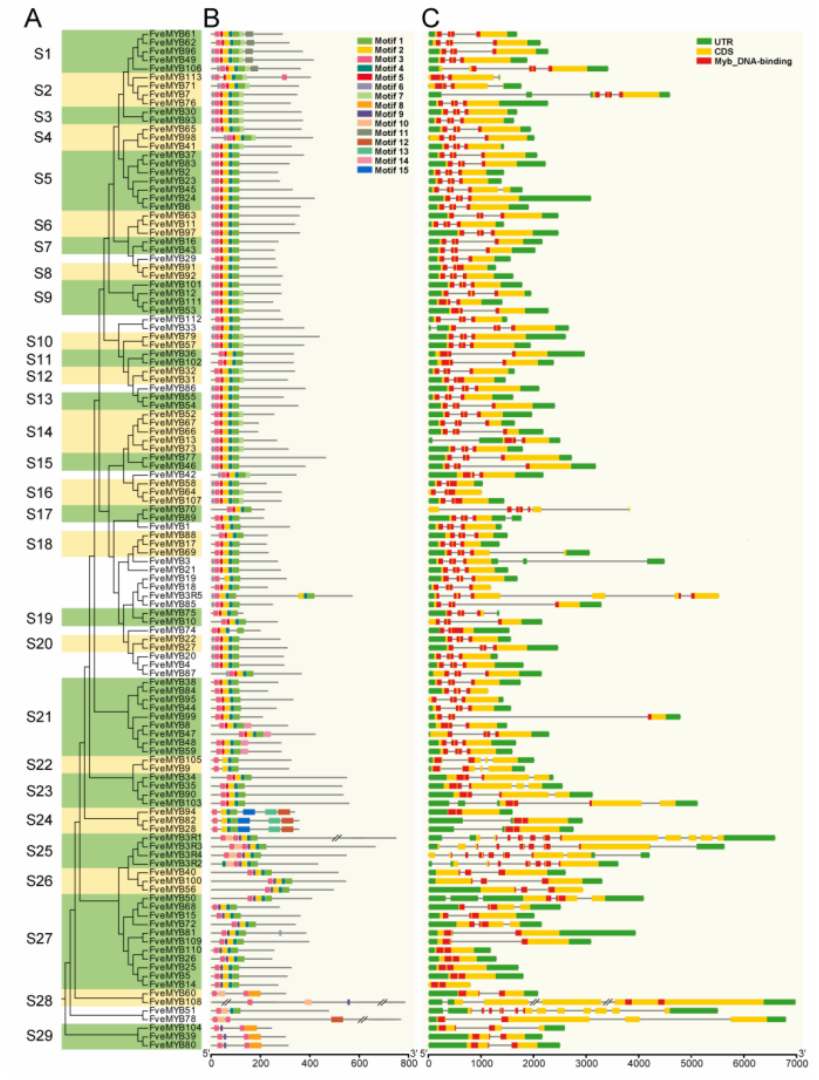
Figure 1. The phylogenetic relationship, conserved motif structure, domain, and intron – exon organization of 2R-MYB and 3R-MYB proteins in woodland strawberry. ( A ) The phylogenetic tree of five 3R-MYB proteins and 113 2R-MYB proteins in woodland strawberry. According to previous study in soybean [26], the phylogenetic tree was divided into 29 subgroups (S1 – S29) based on bootstrap values (>50), which had only one R1R2R3 subgroup. Some proteins were not clustered together due to bootstrap values were below than 50. ( B ) The motif composition of 2R-MYB and 3R-MYB proteins from woodland strawberry. Fifteen motifs were marked with different color boxes. ( C ) The domain composition and intron – exon organization of 2R-MYB and 3R-MYB proteins from woodland strawberry. Red boxes represent Myb_DNA-binding domains. The exon structure was shown as yellow CDS (s) and green UTR (s). The space (grey lines) between the boxes were intron(s).